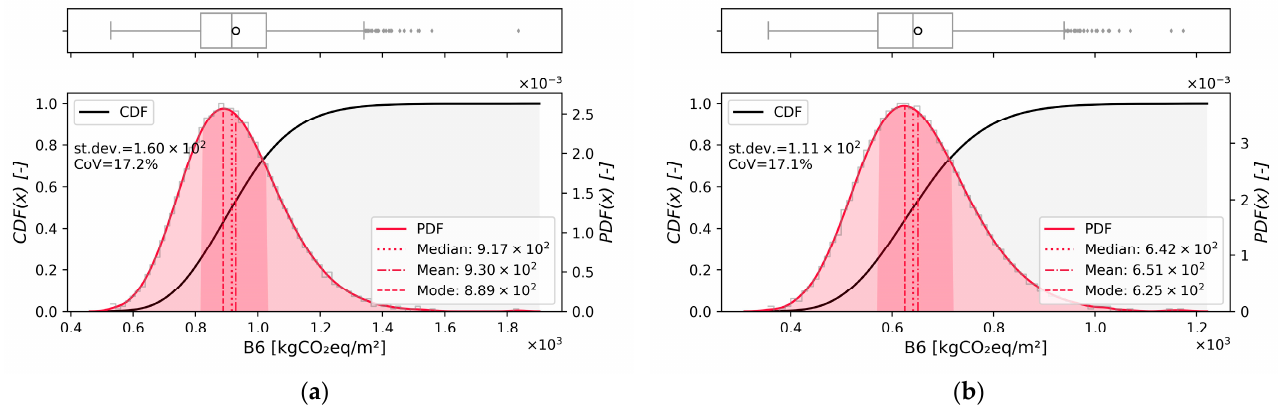
Figure 11. PDFs, CDFs, and box-whisker plots for the GWP due to heat production (B6) in: ( a ) the pre-retro fi t scenario; ( b ) the post-retro fi t scenario.